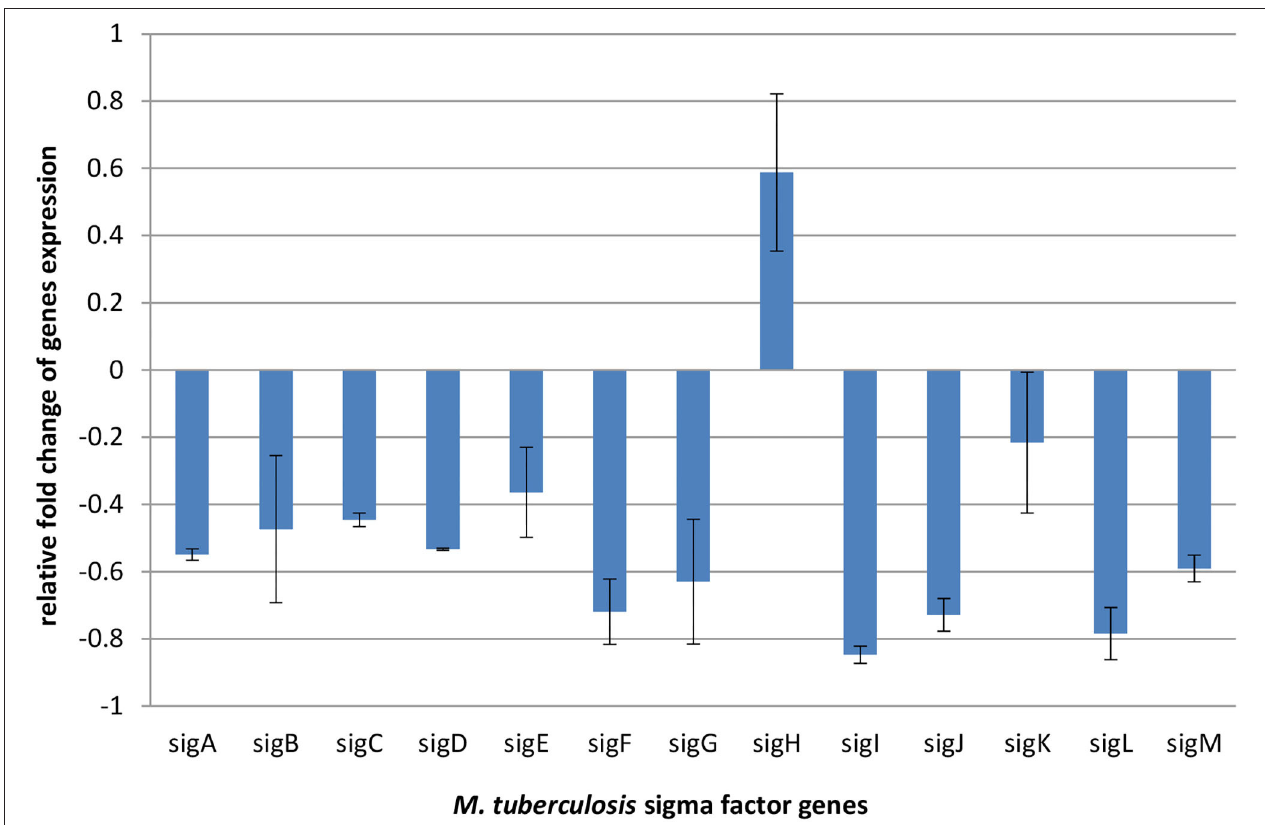
FIGURE 4 | Relative fold change expression of M. tuberculosis H37Ra sigma factors genes after 24h of exposure to an effective dose (256 µ l/ml) of propolis extract, normalized to 16SmRNA (control).